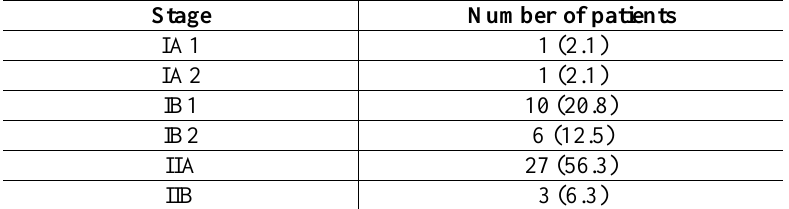
Abbreviation: FIGO = International Federation of Gynecology and Obstetrics